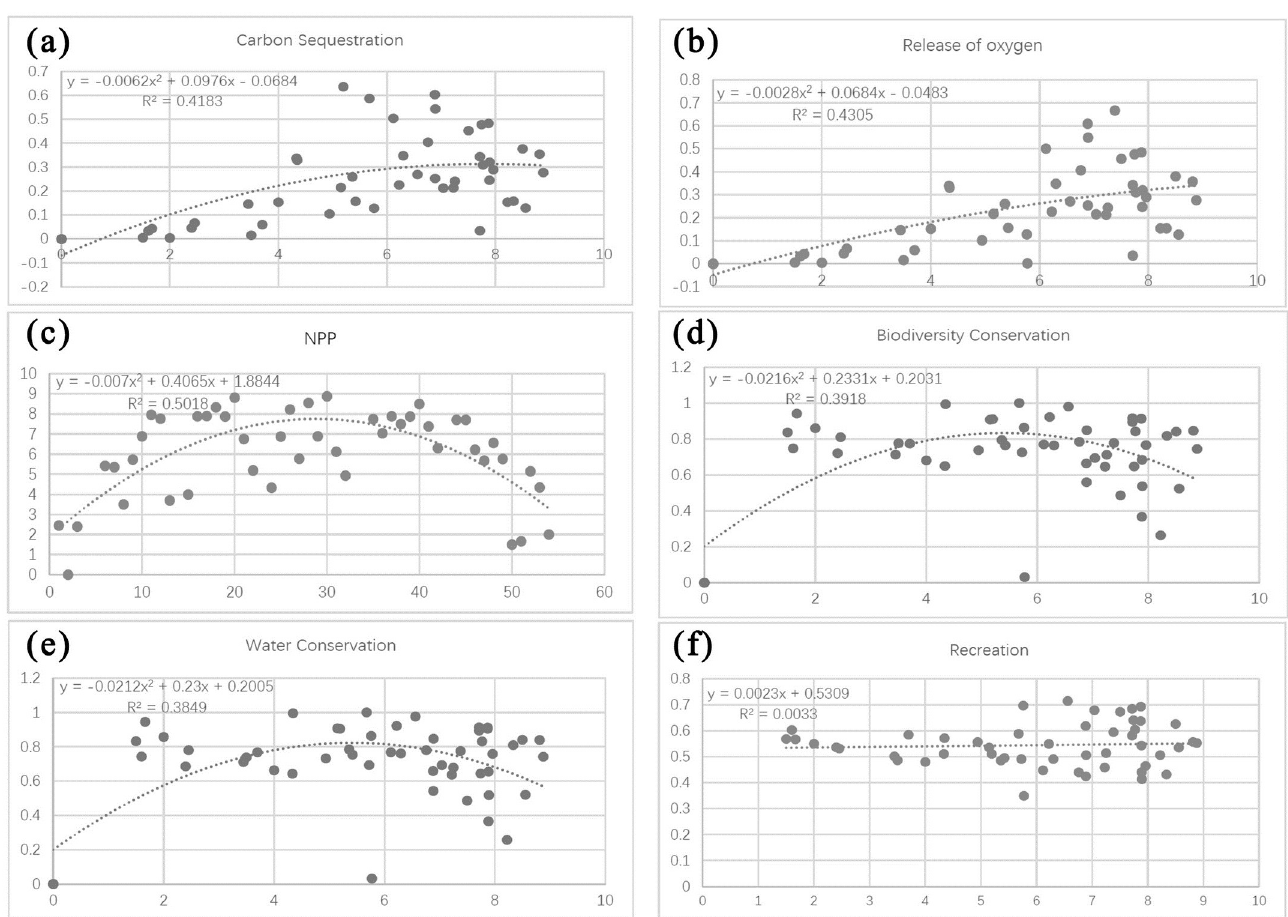
Fig 10. Relationships between the forest landscape shape index (LSI) and different forest ecosystem service functions. Plots show the relationships between LSI and (a) carbon sequestration capacity, (b) oxygen release capacity, (c) NPP capacity, (d) biodiversity conservation capacity, (e) water conservation capacity, and (f) recreation